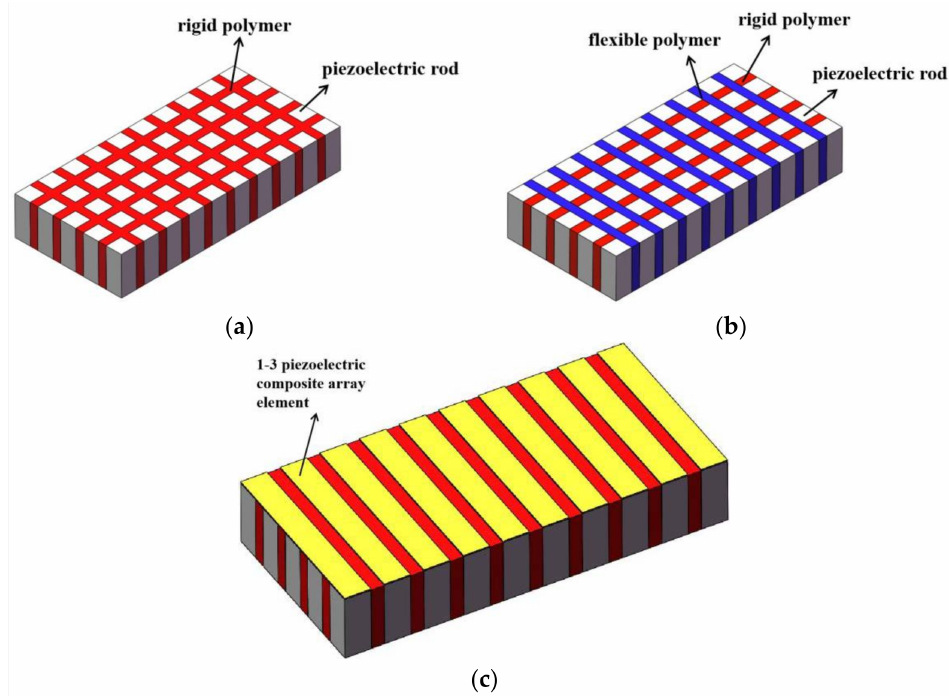
Figure 1. Two types of 1–3 piezoelectric composite and array structure. ( a ) Two-phase of 1–3 piezoelectric composite; ( b ) Three-phase of 1–3 piezoelectric composite; ( c ) Structure of 1–3 piezoelectric composite array.